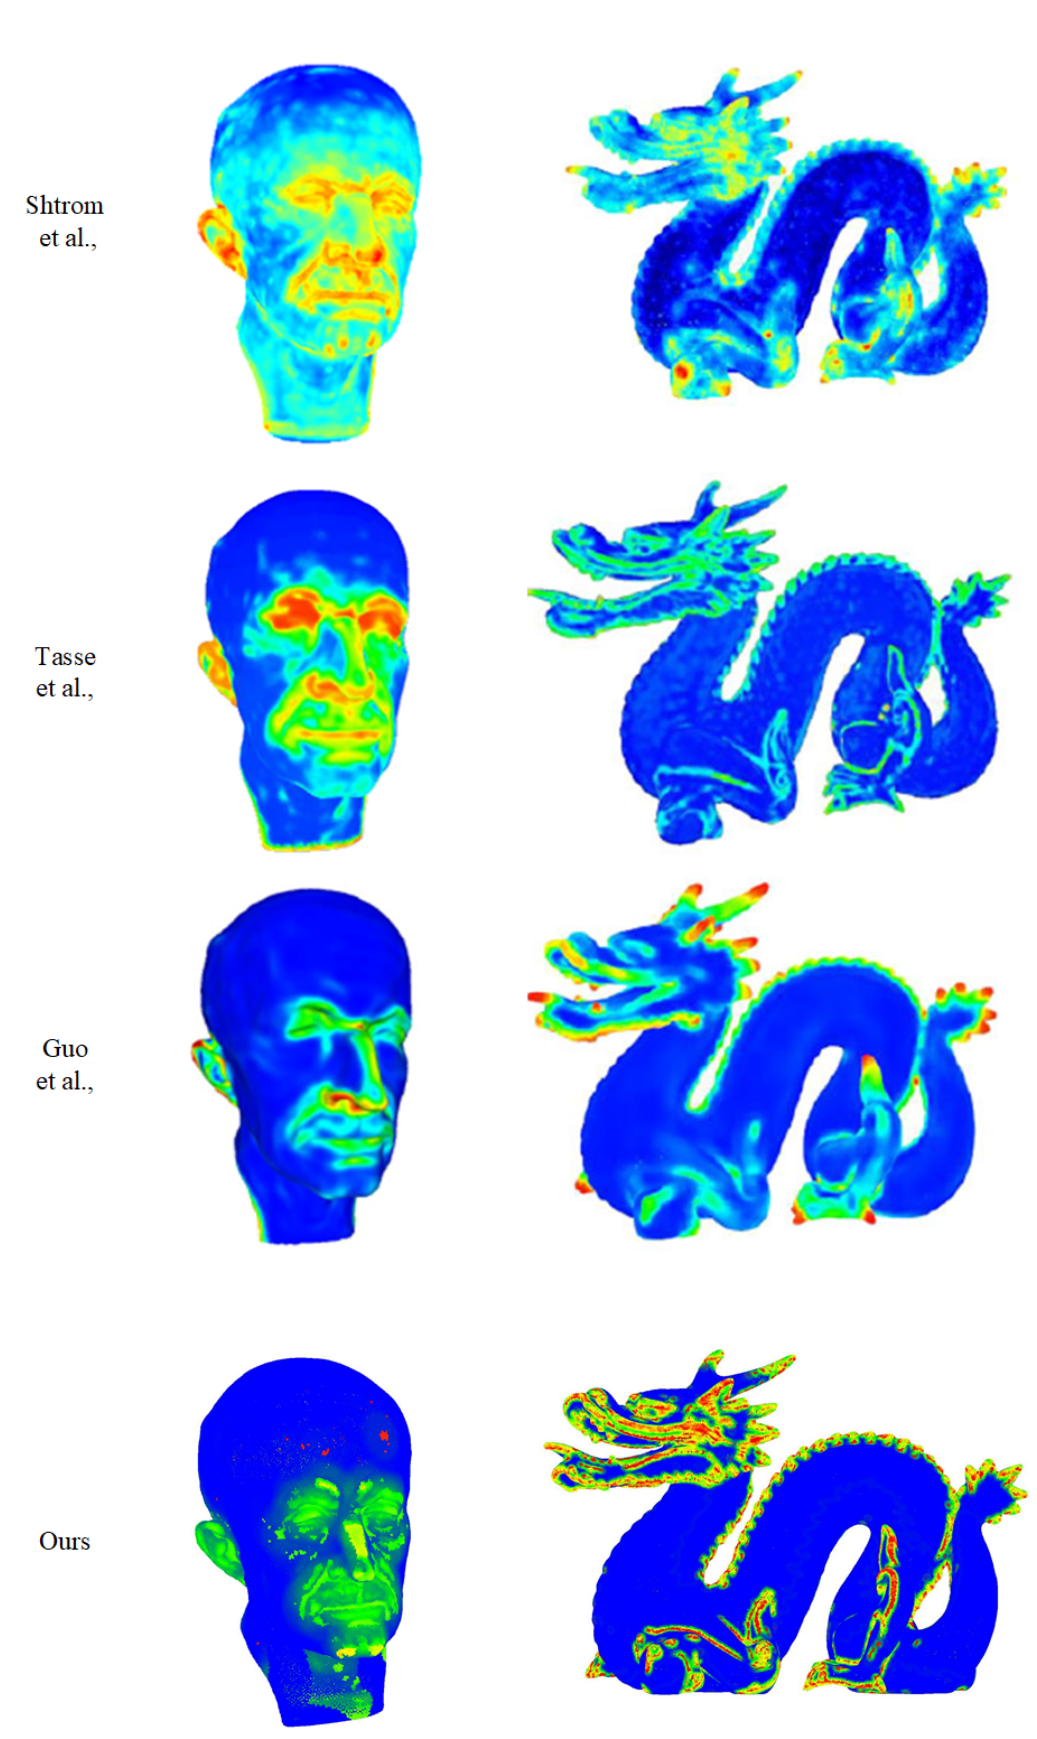
Figure 3. Comparison with point-based saliency estimations of two watertight benchmark